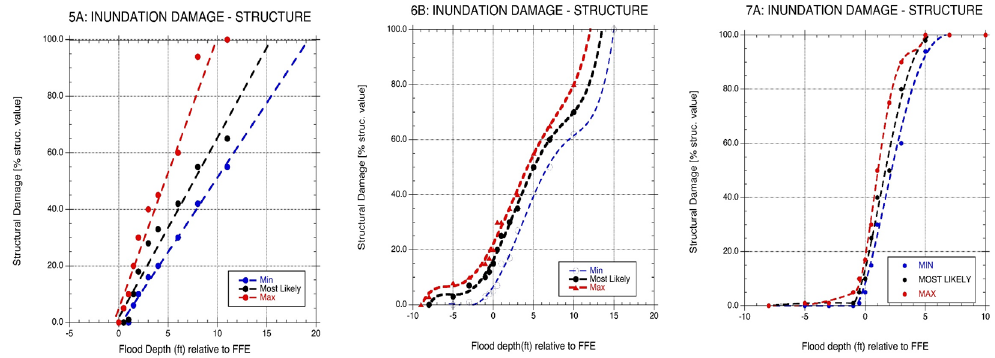
Figure 3. ACOE NACCS [5] structure damage curves for inundation for Prototypes 5A, 6B, and 7A. Minimum, most likely, and maximum curves are provided for each. All plots are percent damage vs. elevation relative to FFE. J. Mar. Sci. Eng. 2016 , 4 , 54